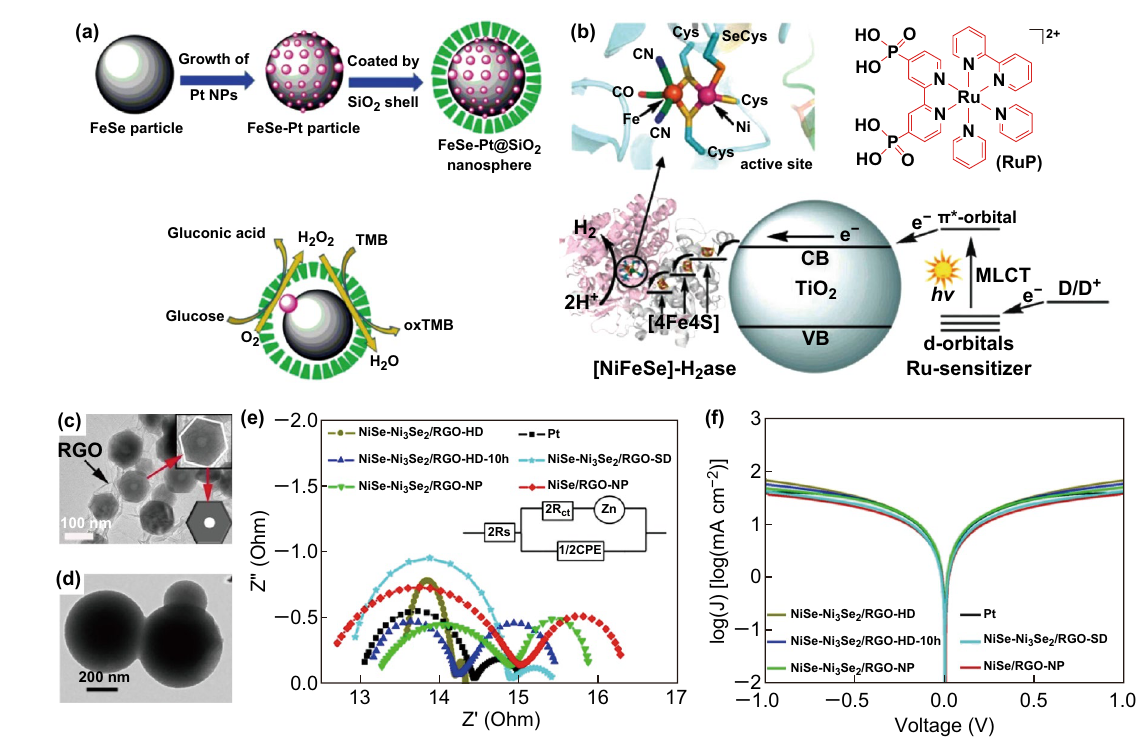
Fig. 14 a Preliminary synthesis and enzyme cascade mechanism of FeSe-Pt@SiO 2 nanohybrids. b Visible light drives H 2 evolution of RuP– TiO 2 -H 2 ase. TEM image of c NiSe–Ni 3 Se 2 /RGO–HD and d FeSe–Pt@SiO 2 microspheres. e Nyquist diagram of symmetrical elements made with NiSeNi 3 Se 2 /RGO series and Pt CE. f Tafel polarization curves of NiSeNi 3 Se 2 /RGO series and Pt CE symmetric cells I − /I 3− . Adapted from Refs. [121, 124, 126] with permission. Copyrights: 2015 (2018), The Royal Society of Chemistry and 2018, American Chemical